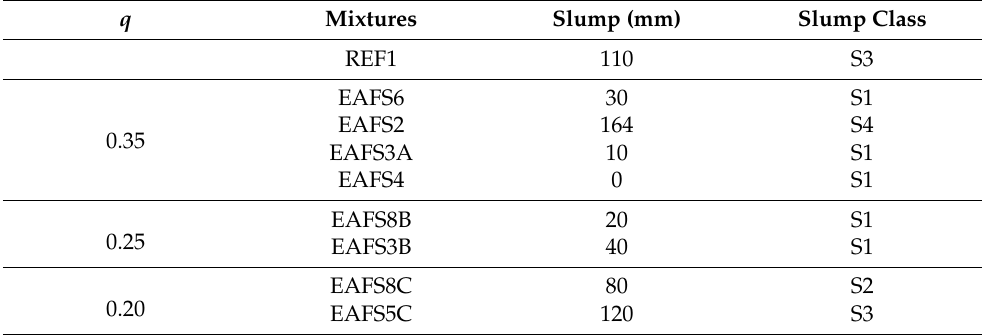
Table 9. Results of the fresh properties reached for the reference mixtures REF1 and REF2 and for the EAFS mixtures.